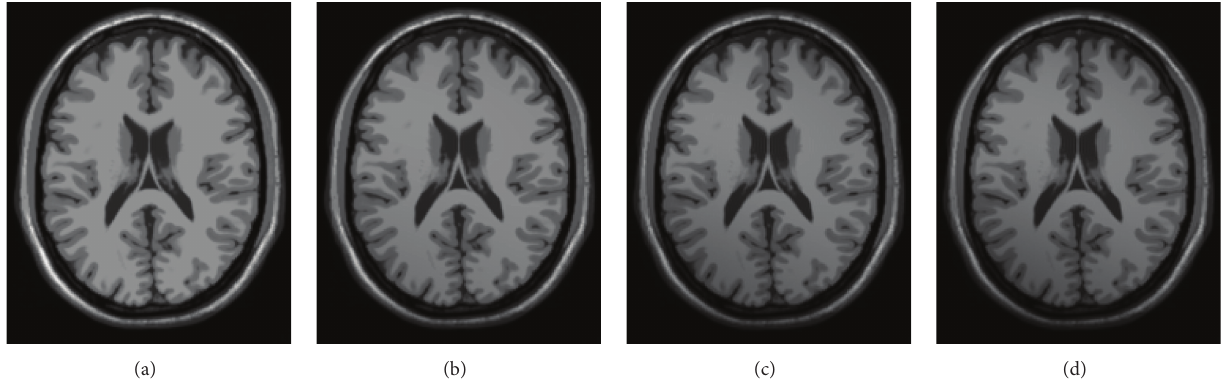
Figure 1: Intensity inhomogeneity in brain MR images. (a) Original brain MR image. The images altered by 40%, 80%, and 100% intensity inhomogeneity in (b), (c), and (d),